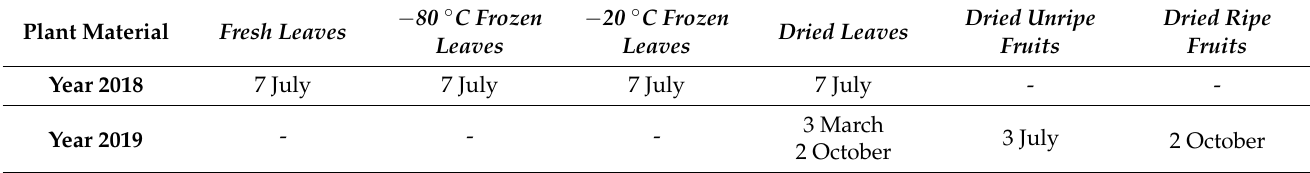
Table 4. Collection details of the analyzed plant samples of Myrtus communis subsp. communis in 2018 and 2019. March corresponds to the onset of the plant vegetative growth, July to the fruiting stage, October to the fruit